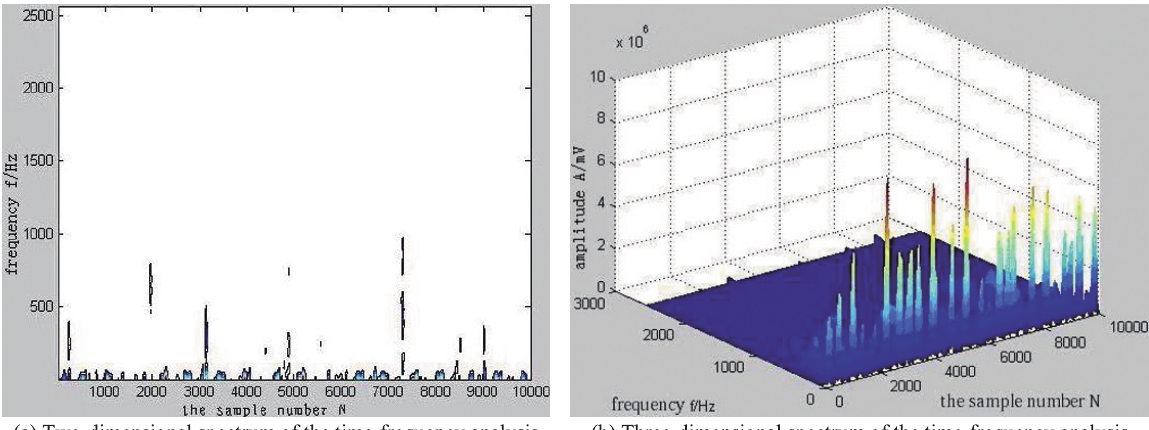
Fig. 7. The time frequency analysis of a pitch circle crack signal at 300 rpm.